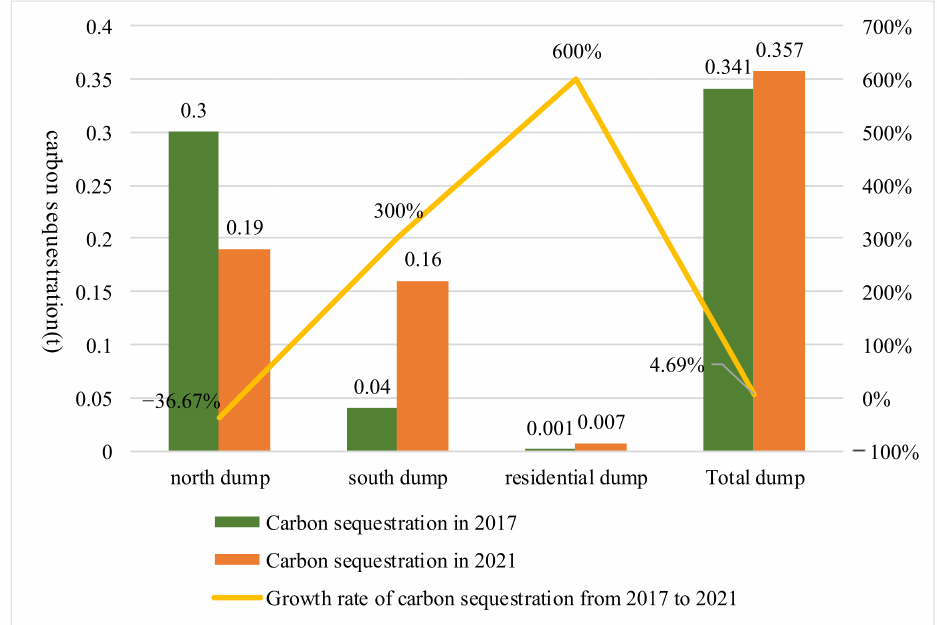
Figure 5. Changes in carbon sequestration in the ecological project area from 2017 to 2021.